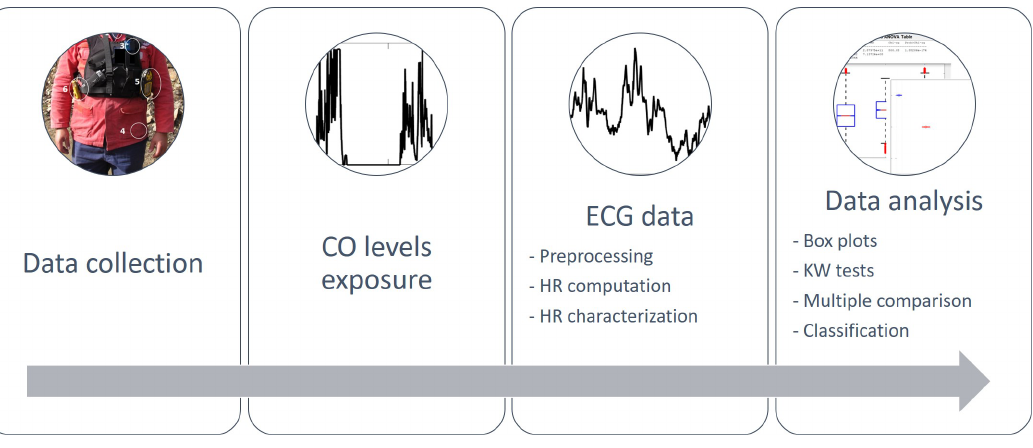
Figure 4. Data analysis